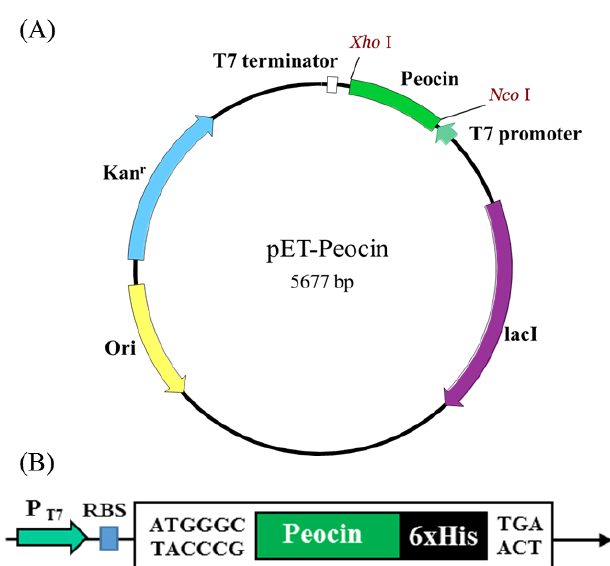
Figure 2. Construction of the recombinant expression plasmid pET-Peocin. ( A ) A synthetic DNA sequence encoding the peocin protein was cloned into pET28b with the Nco I and Xho I restriction sites. Kanr, kanamycin resistance; lac I, lac repressor; ori, origin of replication; ( B ) Diagram illustrating the main features of pET-Peocin. Expression of the peocin gene is controlled by the T7 promoter (P T7 ). RBS, ribosome-binding site.